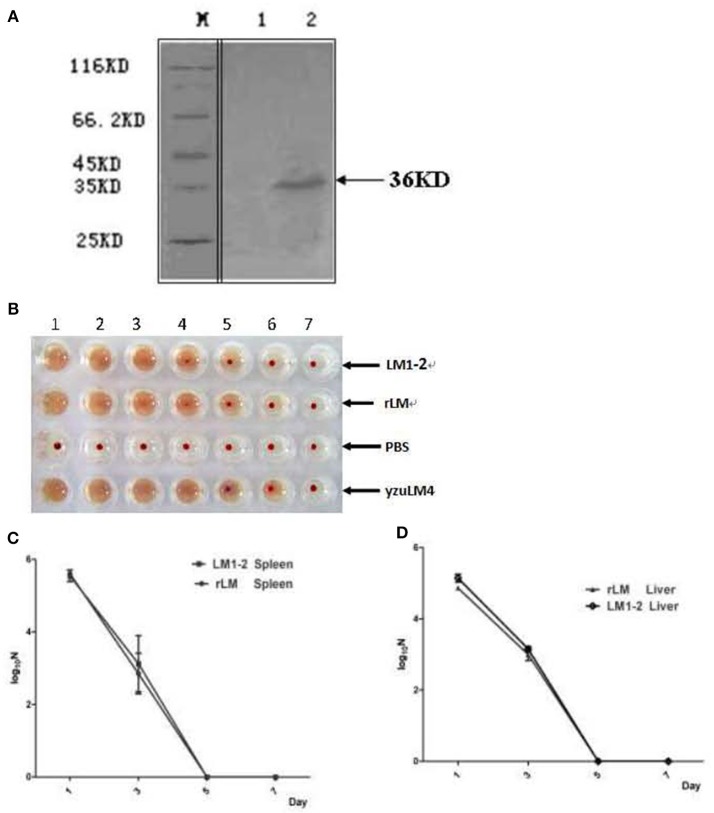
Identification of recombinant L. monocytogenes strain. (A) Western blot analysis of expressed FbpB-ESAT-6 protein. Secreted proteins were TCA-precipitated and probed by a rabbit anti-ESAT-6 monoclonal antibody by western blot. M represents protein marker; lane 1 represents proteins from LM1-2, lane 2 represents the proteins from rLM. (B) Hemolytic activity of listeria strains. Culture supernatants were incubated with sheep erythrocytes at 37°C in two-fold serial dilutions (wells 1–7). The recombinant strain rLM had hemolysis titers of 23, while the parental strains were 24. (C,D) Kinetics of different LM strains during infection in spleens (C) and livers (D) of mice. C57BL/6 mice (20 mice per group) were injected intravenously (i.v.) with rLM and LM1-2 at a dose of 0.1 LD50, respectively. Bacteria in spleen and liver were enumerated on day 1, 3, 5, and 7 post-inoculation by tissue homogenization and serial plating.